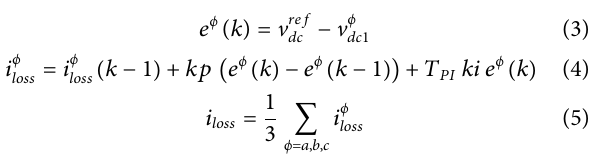
Frontiers in Energy Research |